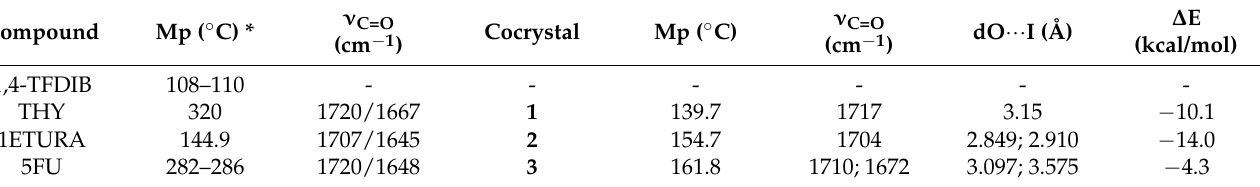
Table 1. Physical data of the starting compounds and the new